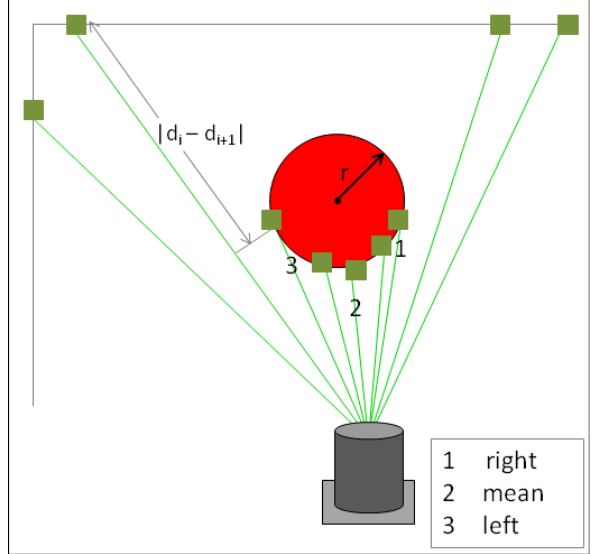
Figure 2: Diagram of depth-jumps at a single pole